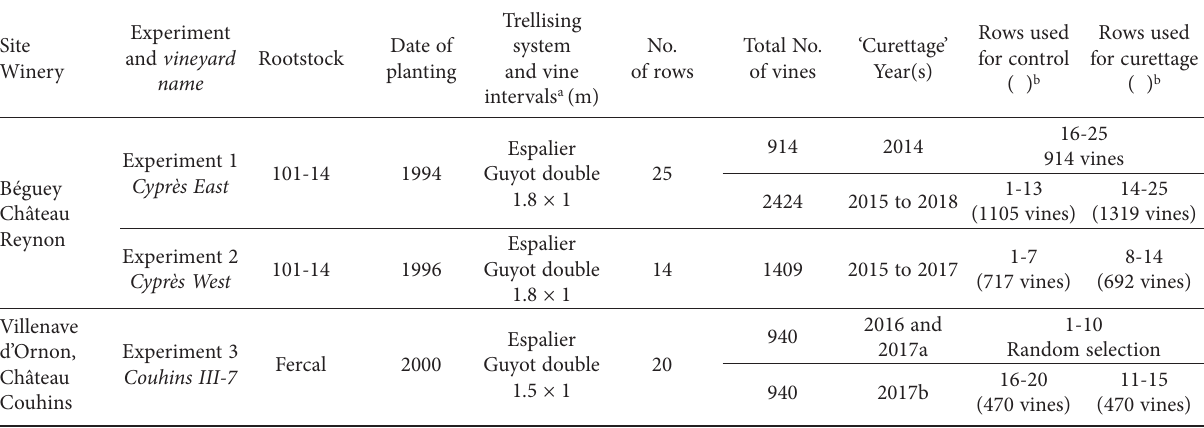
Table 1. Main cropping characteristics of the three ‘Sauvignon blanc’ vineyards used for assessment of ‘curettage’ effects.